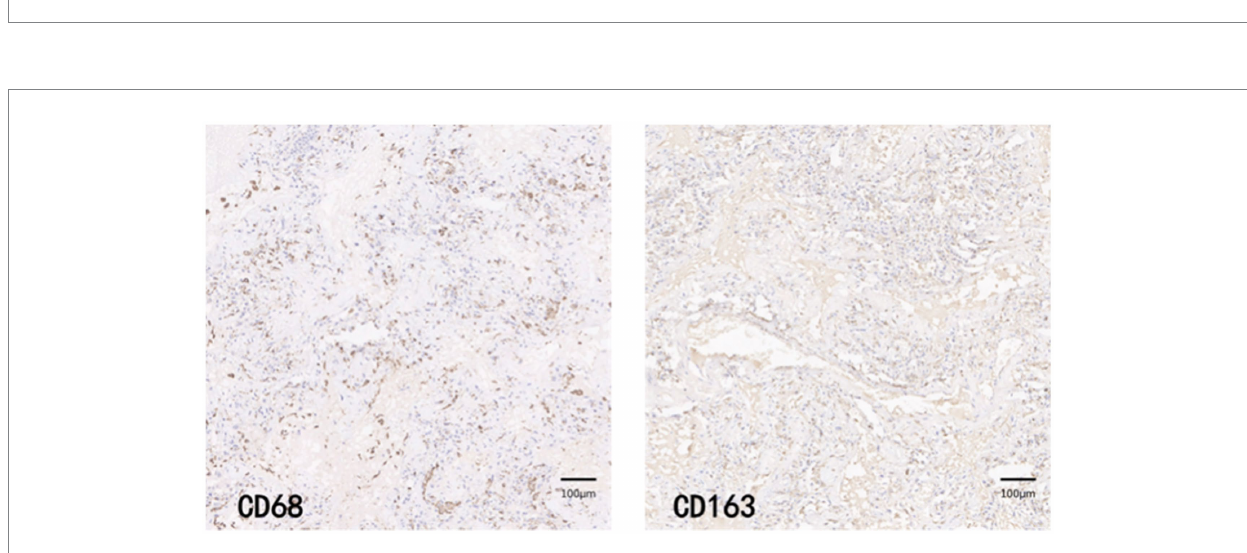
FIGURE 11 COV-H group immunohistochemical staining PATCH (1,600 × 1,600 pixels).